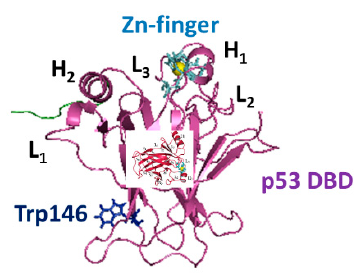
Figure 1. The structure of p53 DNA binding domain (DBD) derived from the chain B of PDB entry 1 TUP, with the addition of the 290–300 AA portion (colored in green). The Zn-finger and Trp146 are shown as sticks, while Zn as a yellow sphere.